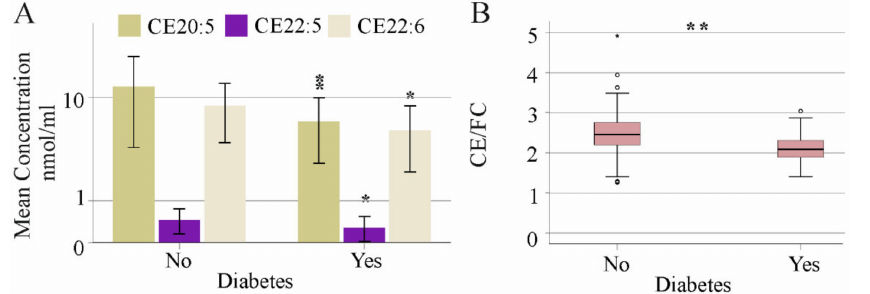
Figure 1. Serum cholesteryl ester (CE) species in relation to diabetes in patients with chronic HCV. ( A ) CE species, which differ in patients with and without diabetes. ( B ) CE/FC ratio of patients with and without diabetes * p < 0.05, ** p < 0.01. Small circles above the boxes mark